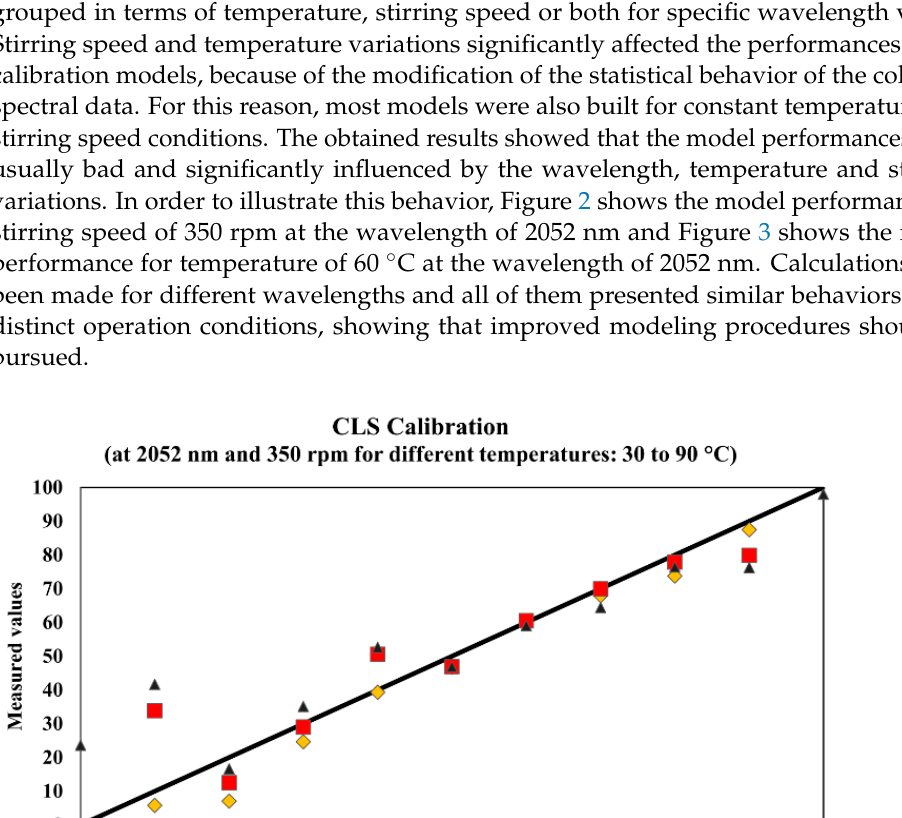
Figure 3. Simple linear calibration model performance at 2052 nm for temperature of 60 °C. 3.2.2. Analysis of the V x Matrix In order to analyze the structure of the covariance matrix of measurement error, V x , 80 spectral measurements were performed for a solution containing 20 vol% xylene and 80 vol% toluene at 30 °C and stirring velocity of 250 rpm. Then, the 79 eigenvectors and eigenvalues of the V x matrix were calculated. From this analysis it could be concluded that not more than four eigenvalues were sufficient to explain 99% of the total variability of the problem, clearly indicating the small number of sources of variability in the system (when compared to the number of spectral responses, m ) and the numerical problems re- lated to the inversion of V x , as described previously and completely neglected in the avail- able NIR literature. This can be regarded as a particularly important result, because it